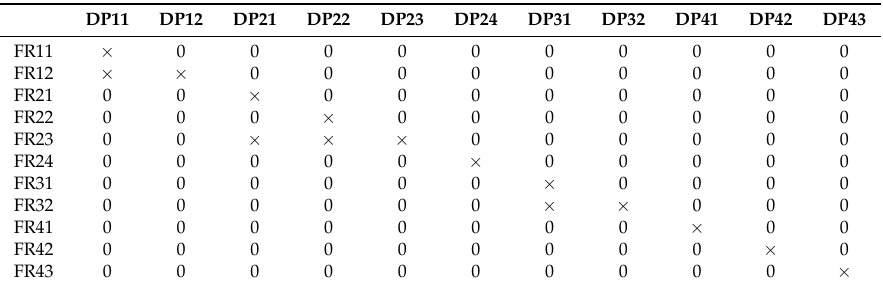
Table 3. Construction of the design